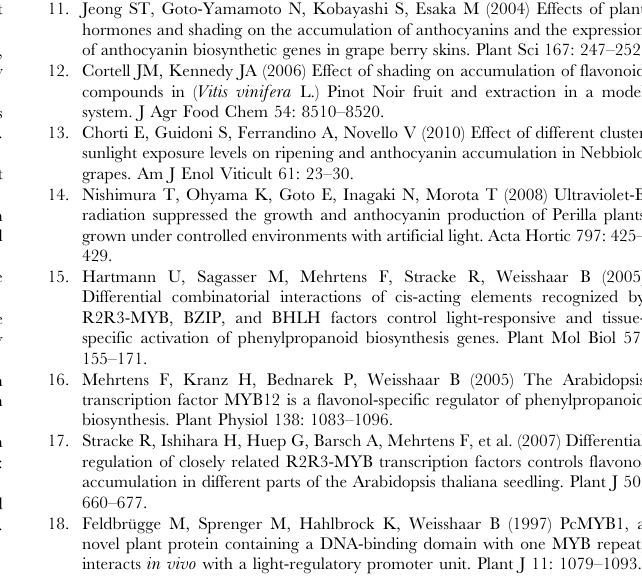
Figure S1 ‘Jingxiu’ and ‘Jingyan’ grape clusters at maturity. Figure S2 Accumulation of Solexa total tags in ‘Jingxiu’ and ‘Jingyan’ grape skins. Table S1 Numbers of down-regulated or up-regulated genes with log2 ratio $ 2 in grape berry skin. Table S2 List of differentially expressed genes with Log2Ratio . =2 in grape berry skin. Table S3 Forward (F) and reverse (R) primers and expected amplicon sizes of genes for